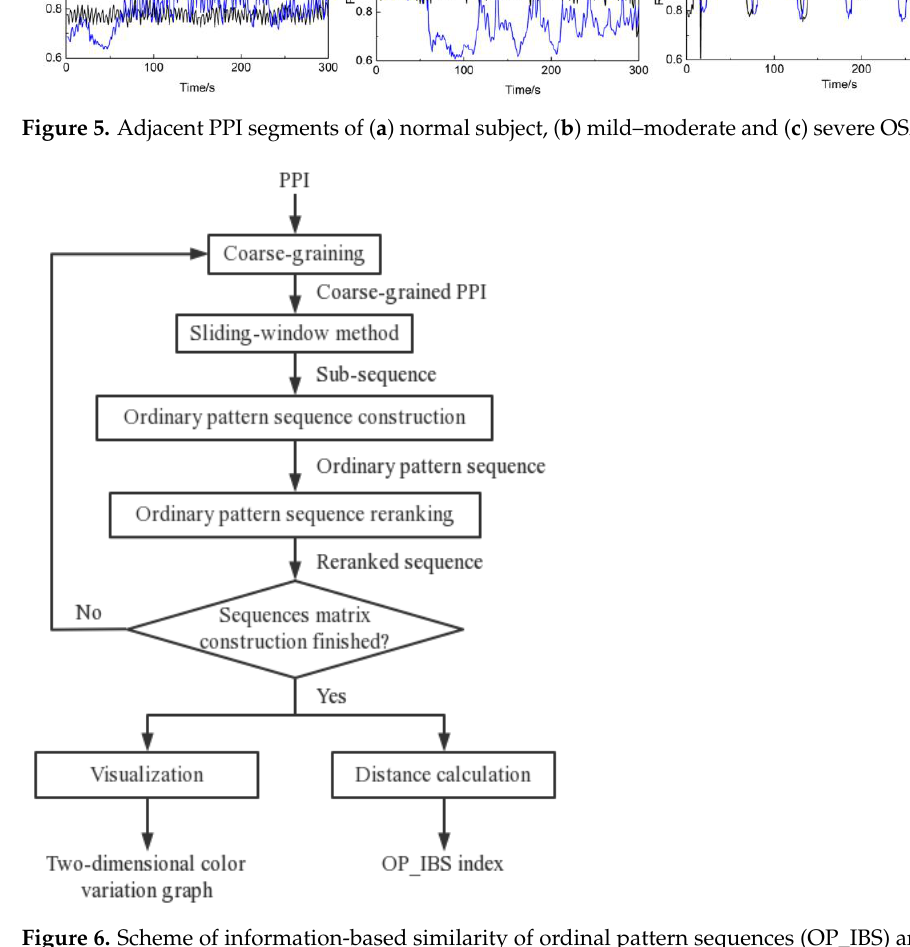
Figure 6. Scheme of information-based similarity of ordinal pattern sequences (OP_IBS) analysis.